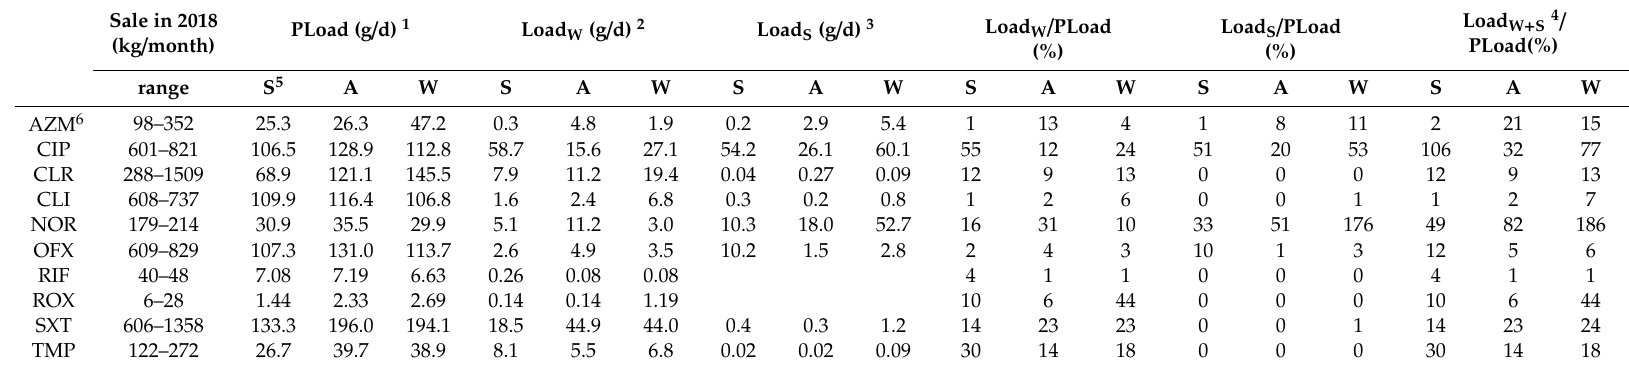
Table A1. The comparison of the predicted (PLoad) and measured load of antimicrobial into